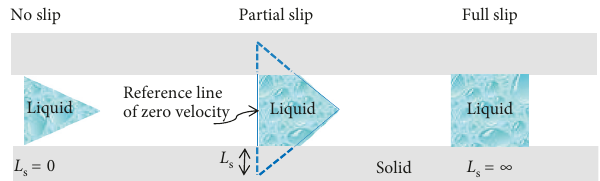
Figure 5: Schematic to illustrate liquid slip on a stationary solid surface.